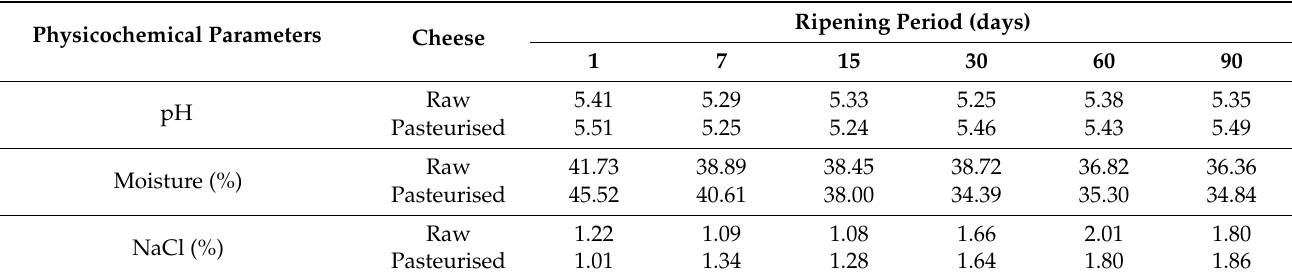
Table 4. Mean values of pH, moisture and NaCl content of the cheese samples during the ripening period of the seven cheesemaking